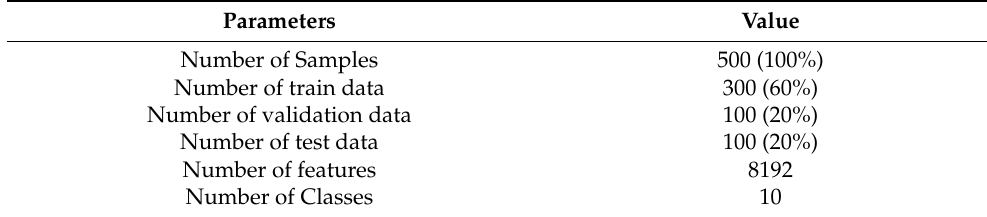
Table 5. Summary of the dataset